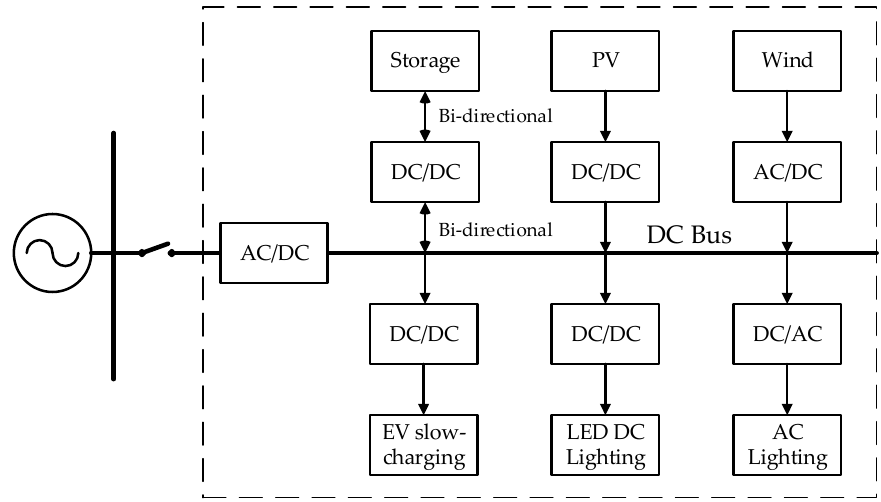
Figure 3. The smart hybrid pole with renewable energy, street lighting, and electric vehicle (EV) charging. LED: light-emitting diode.